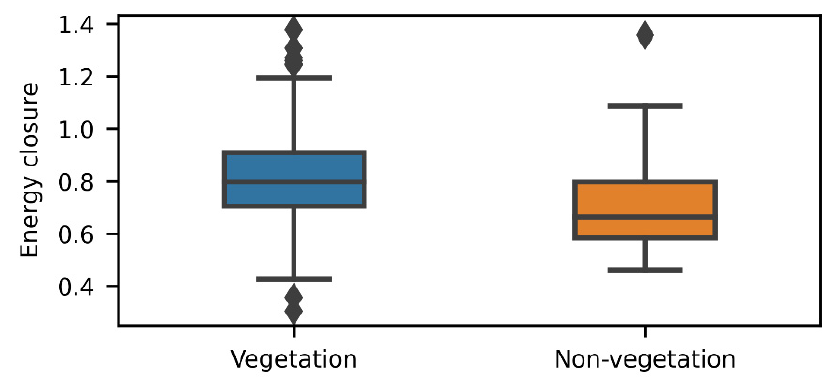
Figure 11. The boxplots of energy closure on vegetation and non-vegetation surfaces from WAPT model during June to September in 2012.